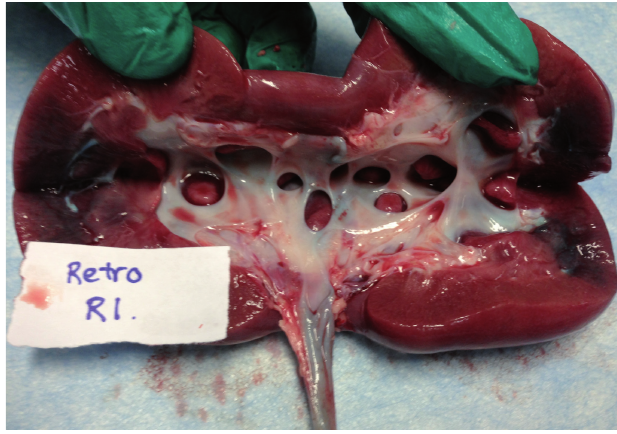
figure 3 - Representative image after percutaneous dye delivery.